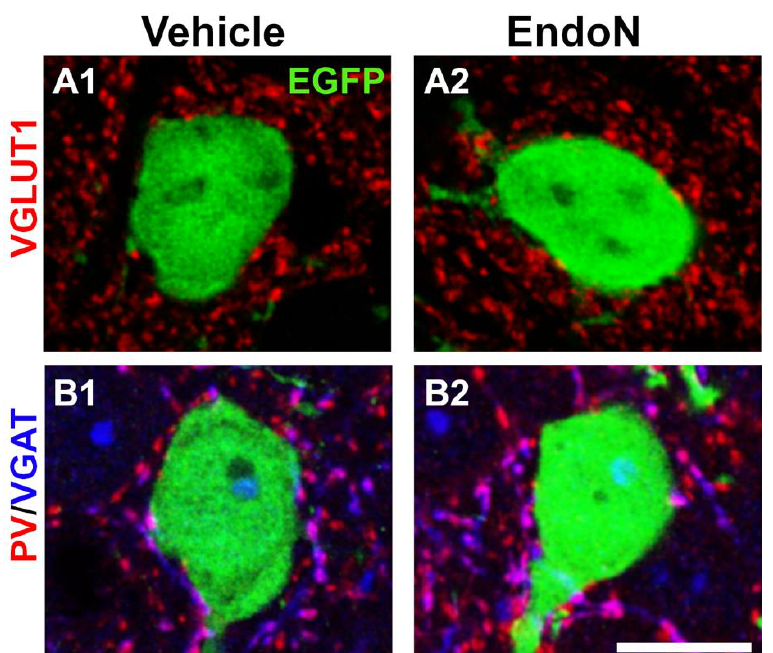
Figure 8. Excitatory and inhibitory puncta in the perisomatic region of EGFP + complex cells in the PCX layer II. ( A , B ) 2D projections of single confocal stacks showing VGLUT1 + ( A , red), VGAT + ( B , blue) and PV + ( B , red) puncta in the perisomatic region of EGFP + complex cells (green) in the vehicle ( A1 , B1 ) and Endo-N ( A2 , B2) injected hemispheres. Scale bar: 10 µm.